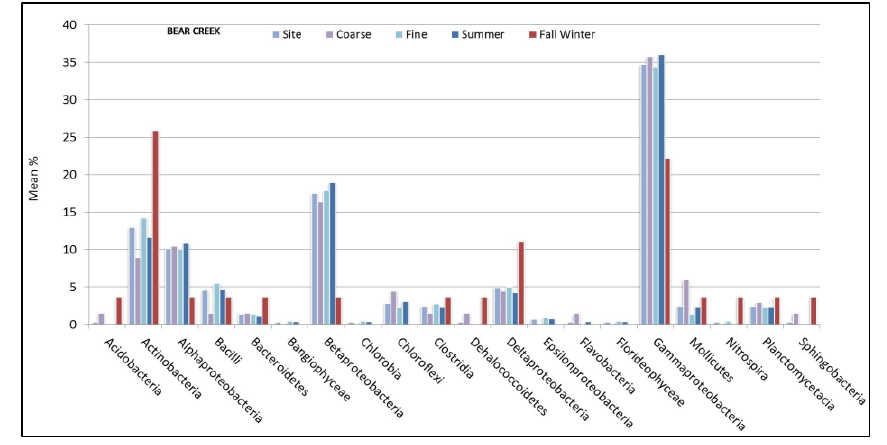
Figure 3. Bear Creek mean % values of OTU matches for bacterial class represented by sediment size and seasonal sampling period.